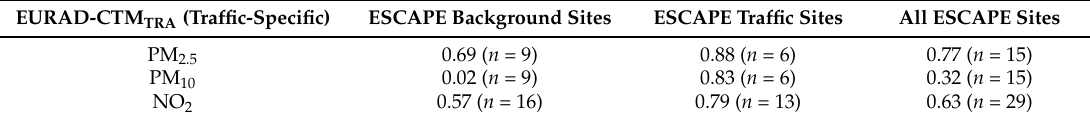
Table 5. Spearman correlation coefficients between 14-day series of measurements at ESCAPE-LUR- monitoring stations and 14-day mean estimations of EURAD-CTM TRA in respective grid